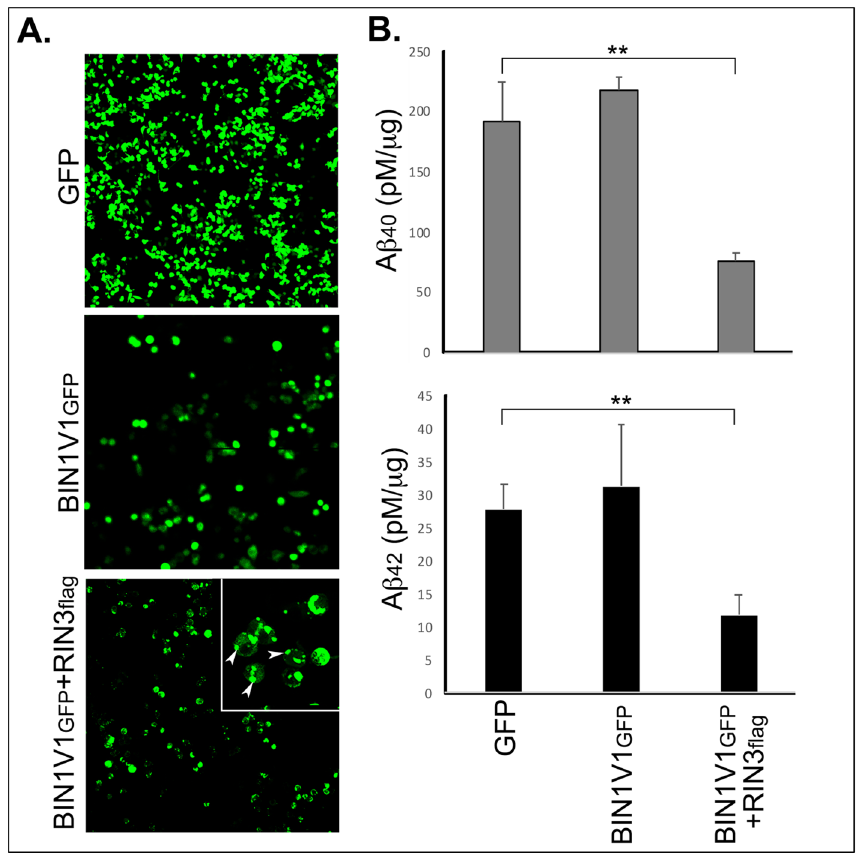
Figure 4. Co-expression of RIN3 with the neuronal isoform BIN1V1 in N2A APP cells reduces Aβ generation. ( A) Representative confocal image of N2A APP cells expressing GFP, BIN1V1 GFP or BIN1V1 GFP + RIN3 flag . GFP and BIN1 GFP exhibited predominant cytoplasmic distribution. BIN1V1 GFP distributed in discrete puncta ( Inset , arrowheads) in cells when co-expressed with RIN3 flag (BIN1V1 GFP + RIN3 flag ). ( B) Condition media of FACS sorted cells overexpressing BIN1V1 GFP or BIN1V9 GFP + RIN3 flag were subjected to Aβ ELISA assay to measure Aβ 40 and Aβ 42 levels. Error bars represented ± SEM from three independent experiments. ** represents p <